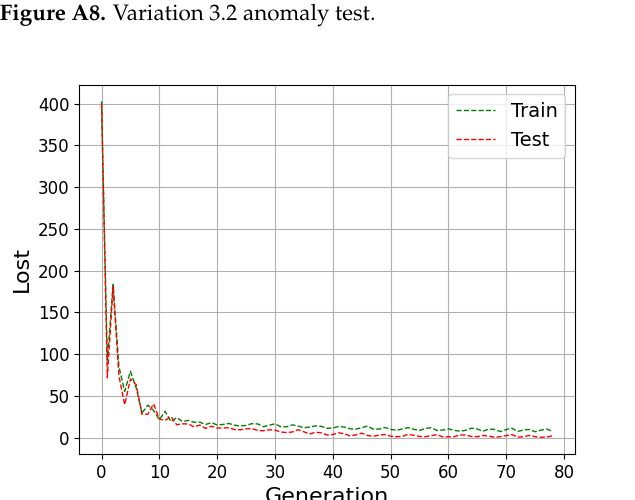
Figure A9. Variation 3.3 anomaly